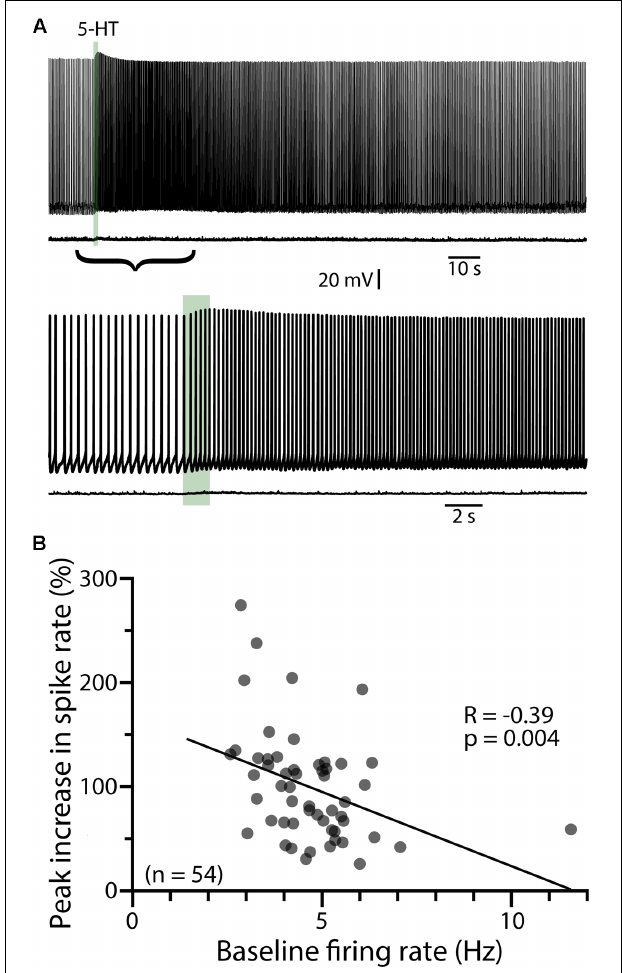
FIGURE 1 | Serotonergic excitation of COM neurons. (A) Voltage traces showing responses to focal application of 5-HT (100 µ M, 1 s, ∼ 15 psi; green bar) during current-evoked action potential generation (above) or at the resting membrane potential of − 74 mV (below). Lower set of traces shows the 5-HT responses at a faster timescale. (B) Plot of peak changes in instantaneous spike frequencies following 5-HT application vs. baseline firing rates for all neurons recorded with standard (i.e., non-BAPTA) pipette solution (see also, Tables 1, 2 ). Regression analysis revealed a negative correlation